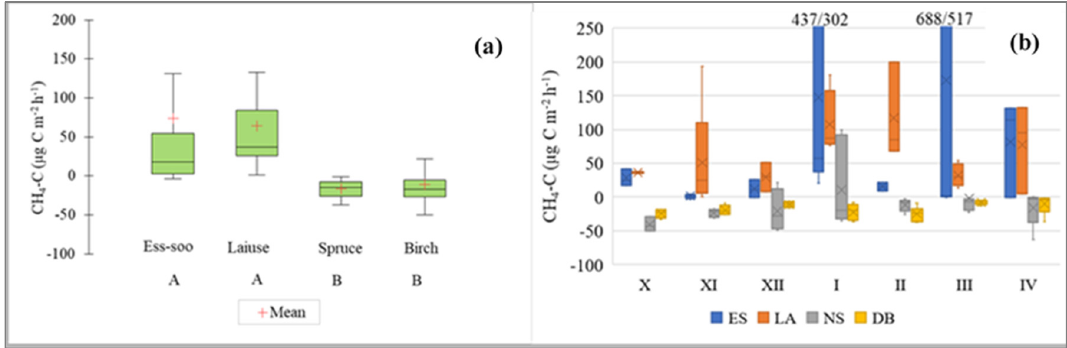
Figure 6. ( a ) CH 4 -C emissions from abandoned peat extraction areas (Ess-soo (ES) (n = 25) and Laiuse (LA) (n = 25)) and drained peatland forests (Norway spruce (NS) (n = 41) and Downy birch (DB) (n = 41)). A and B—significantly differing values (Kruskal–Wallis ANOVA test and multiple comparison of mean ranks test). ( b ) Cold period CH 4 fluxes; X (October) to IV (April)—months. In both figures, the median, 25 and 75% quartile and min/max values are shown. Atmosphere 2020 , 11 , x FOR PEER REVIEW